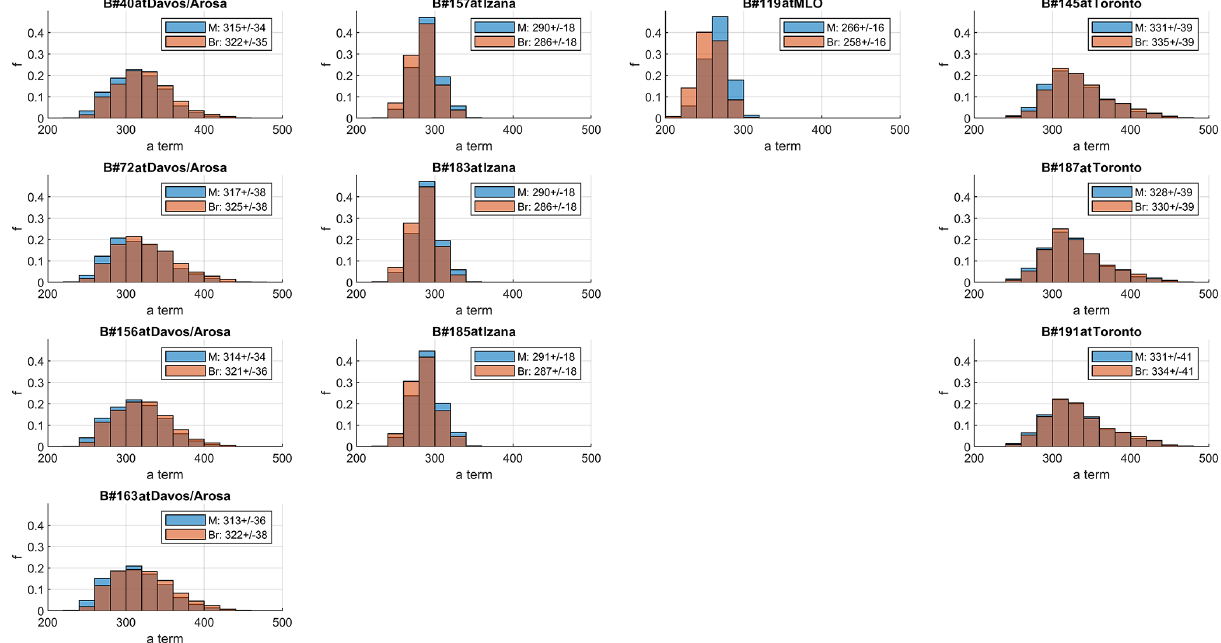
Figure A4. Histograms of second-order polynomial fitting coefficient (zero-order term; constant term) for daily ozone. The values indicated in the legends are the mean ± 1 σ of the